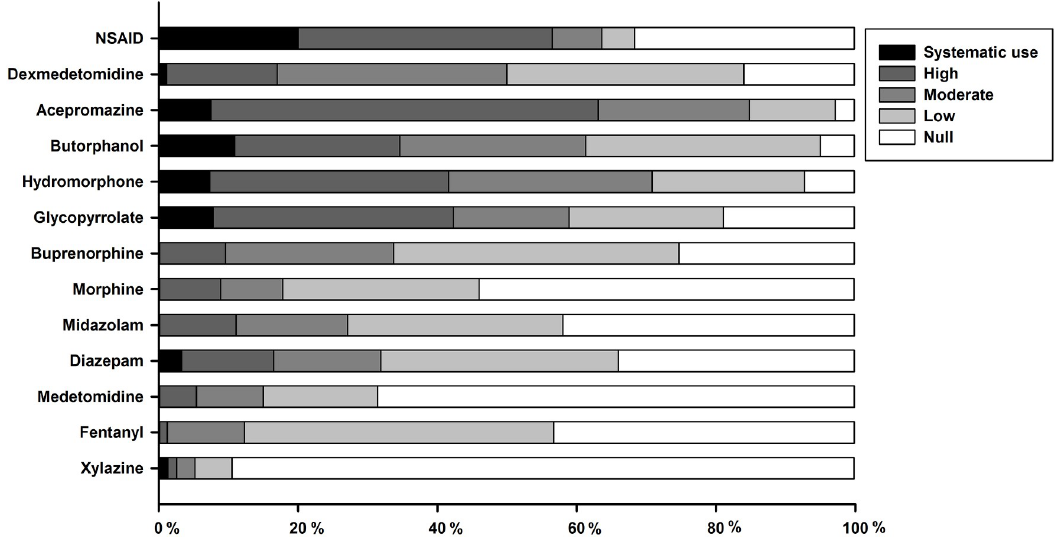
Fig 2. Cumulative percentage of respondents reporting their frequency of use for each drug administered in small animals premedication for routine surgery. Frequency of use is color-coded, as systematic (or 100%), high (61 to 99%), moderate (21 to 60%), low (1 to 20%) or null (or